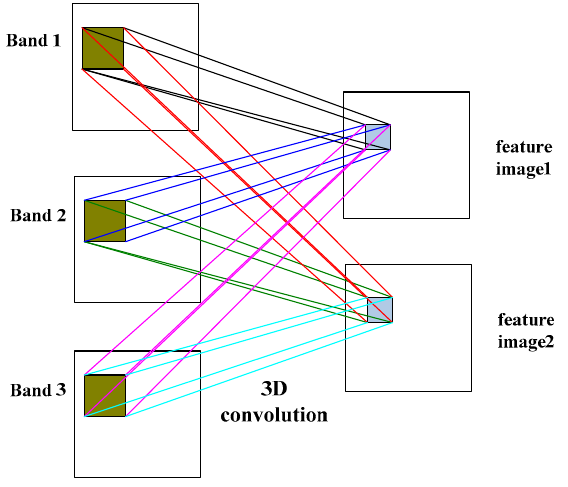
Figure 2. Illustration of the 3D convolution.